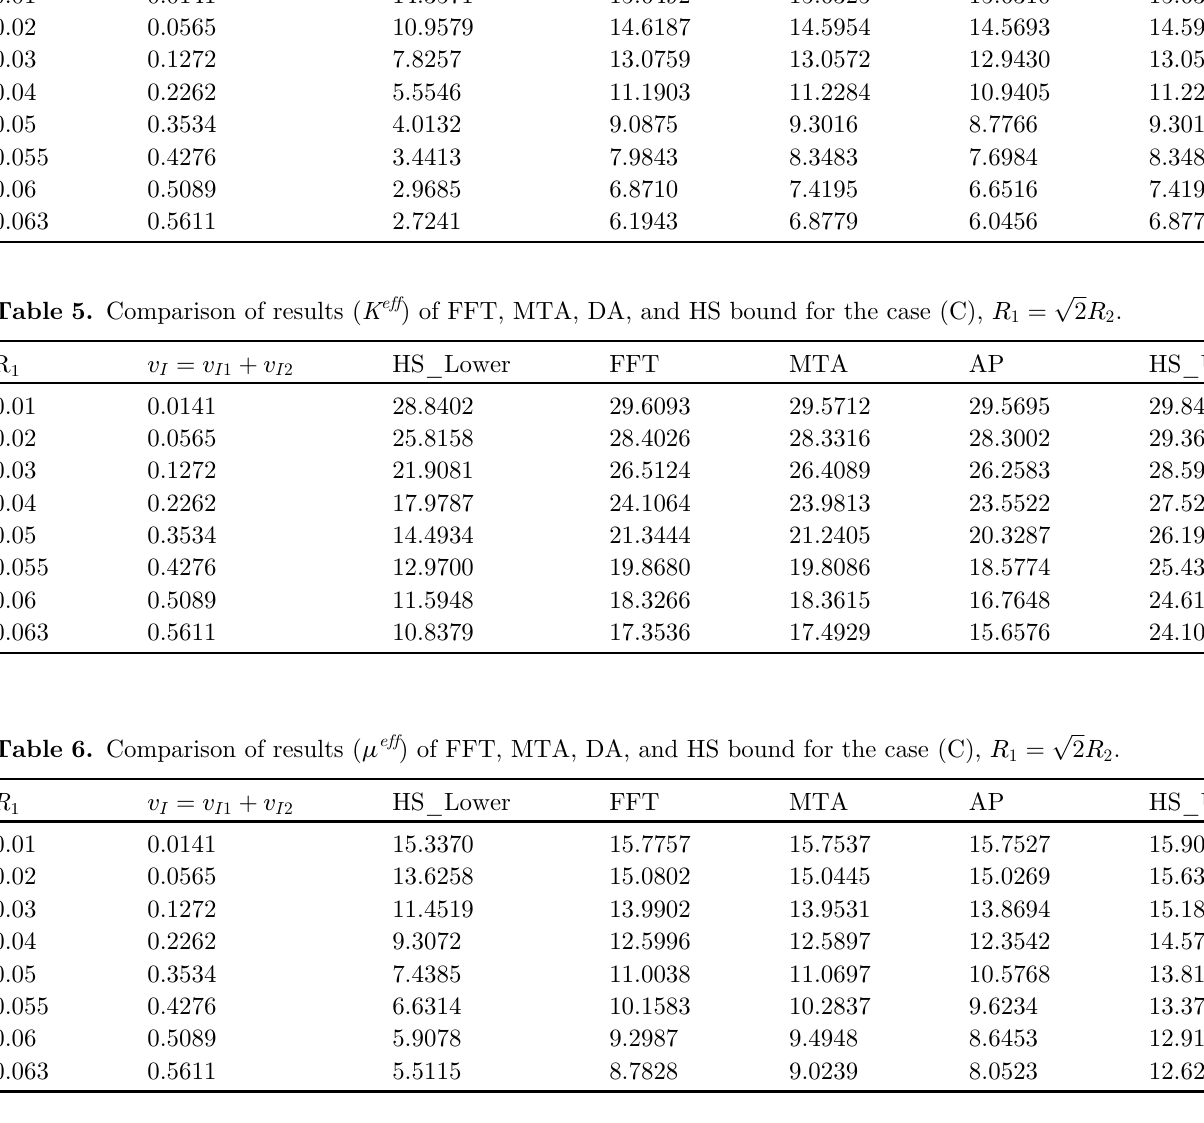
Table 4. Comparison of results ( m eff ) of FFT, MTA, DA, and HS bound for the case (B), R 1 ¼ R 1